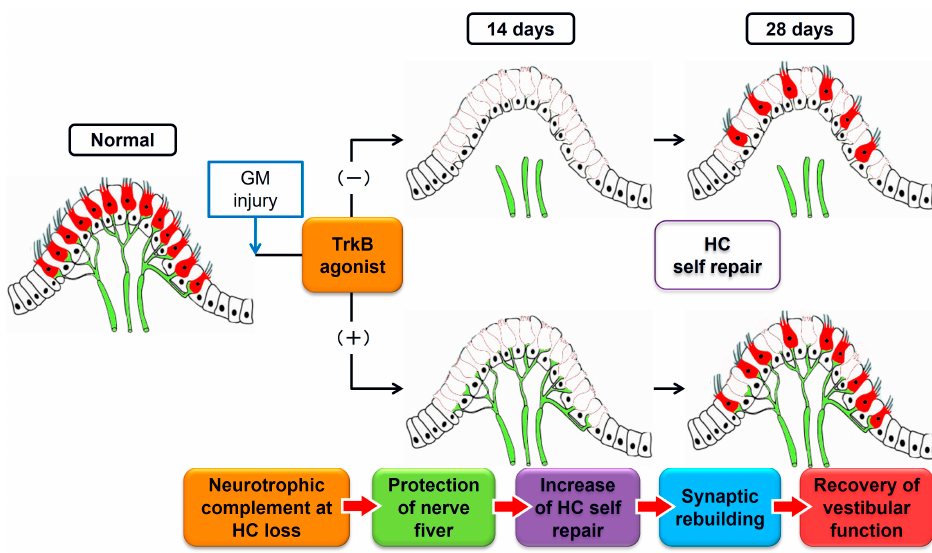
Figure 7. Schematic representations of the effect of oral TrkB agonist